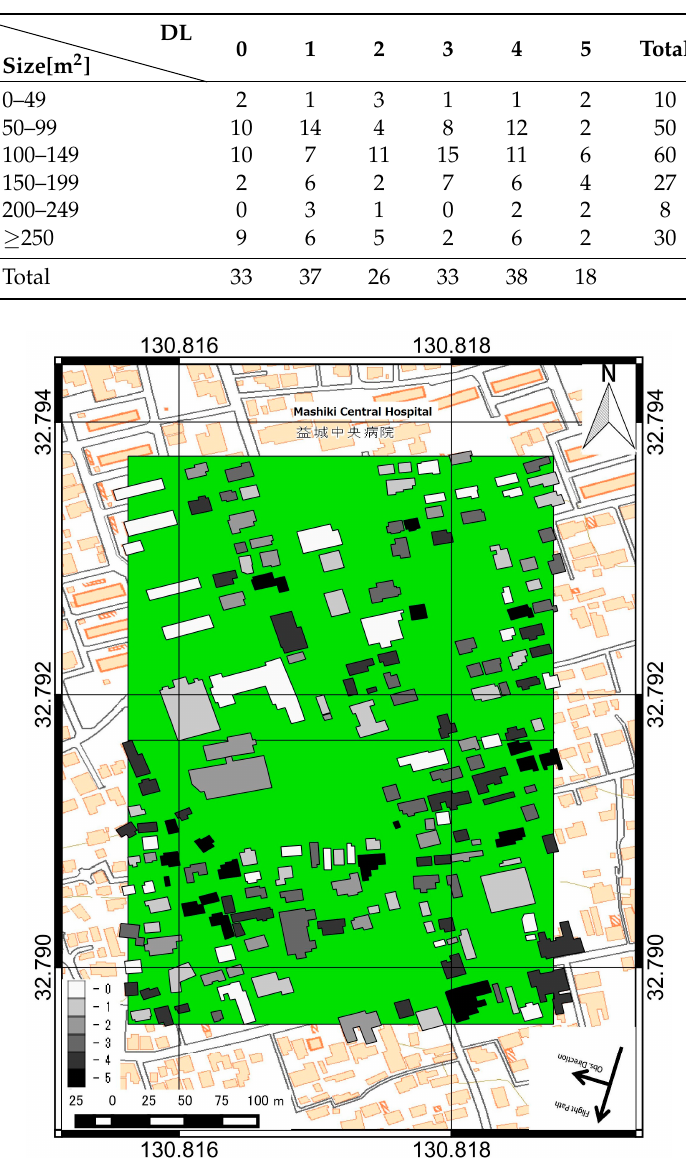
Figure 3. Distribution of the damaged buildings in a sampled region of Mashikimachi town.